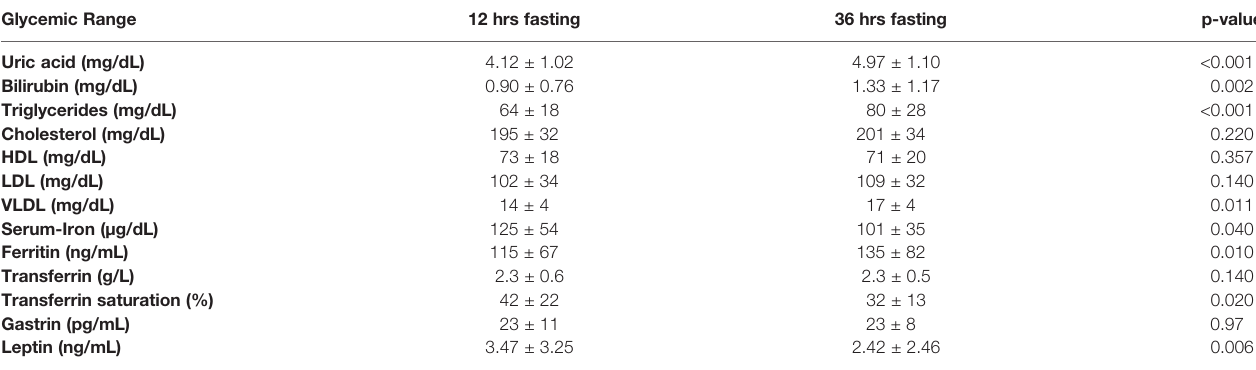
TABLE 2 | Effects of prolonged fasting on metabolic markers (n = 20). Glycemic